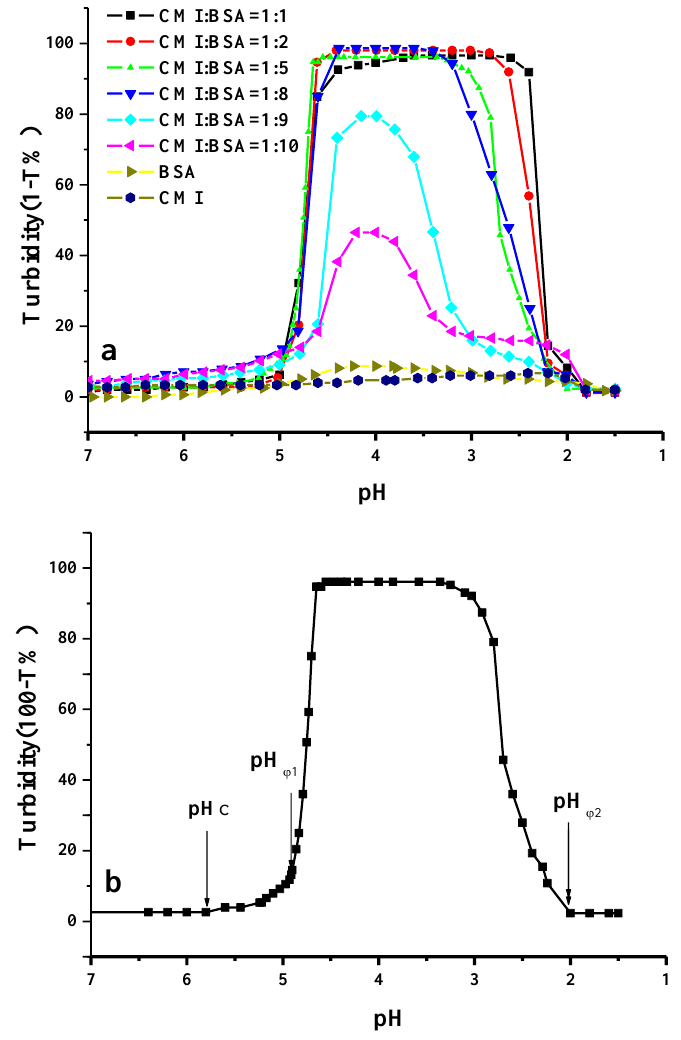
Figure 5. The turbidimetric titration curves of CMI/BSAmixtures as a function of pH at different ratios ( a ) and at CMI/BSA ratio (r) = 1:5 ( b ).